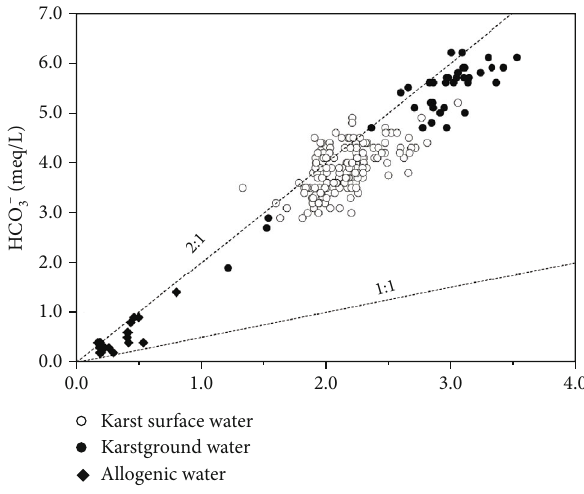
Figure 7: (Ca 2+ +Mg 2+ )/HCO 3- of the surface and underground waters in Shanmuhe Catchment.